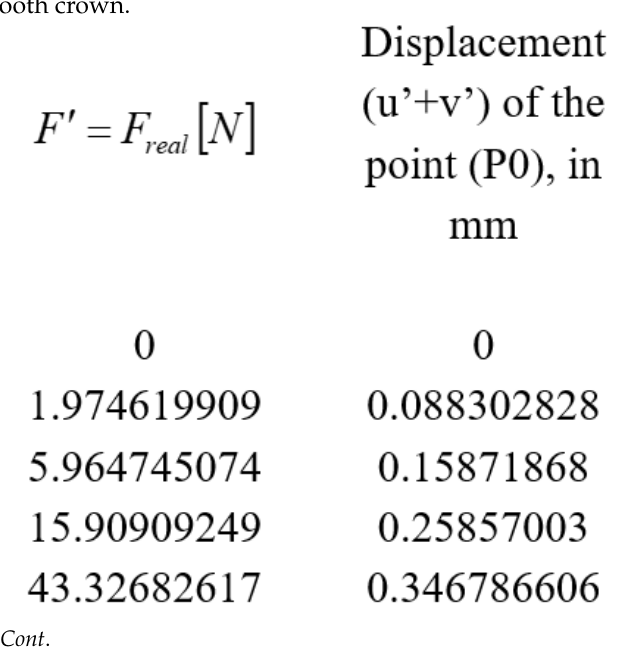
Figure 8. The natural tooth’s displacement during its loading. The curvilinear aspect of the response of the periodontal ligament system of the maxillary natural tooth can be observed. Meanwhile, the unloaded dental implant displacements resulted in a similar, curvilinear aspect (Figure 9).